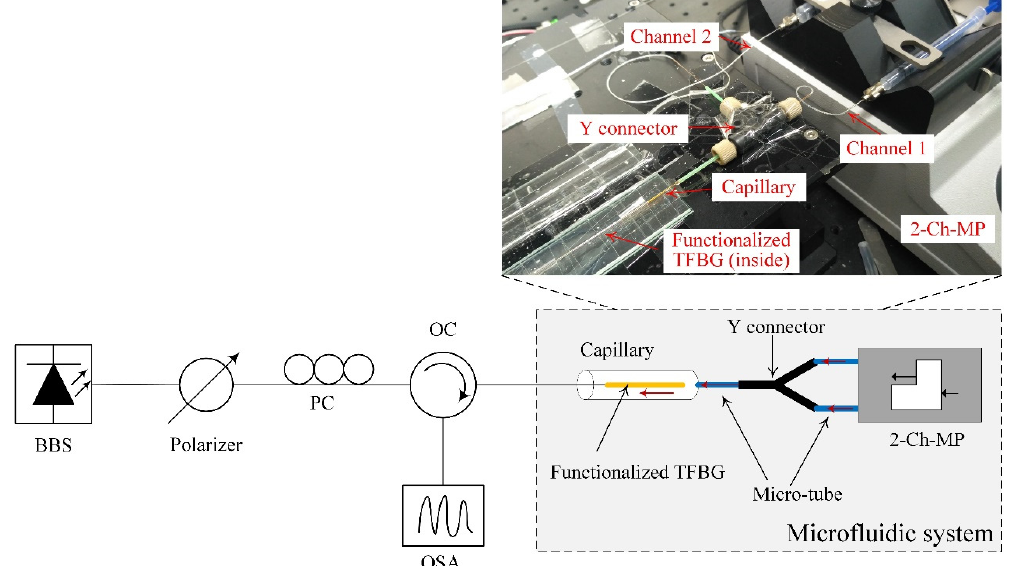
Figure 3. Block diagram of experimental setup. BBS: broadband source; PC: polarization controller; OC: optical circulator; OSA: optical spectrum analyzer; 2-Ch-MP: 2-channel-micro-pump.